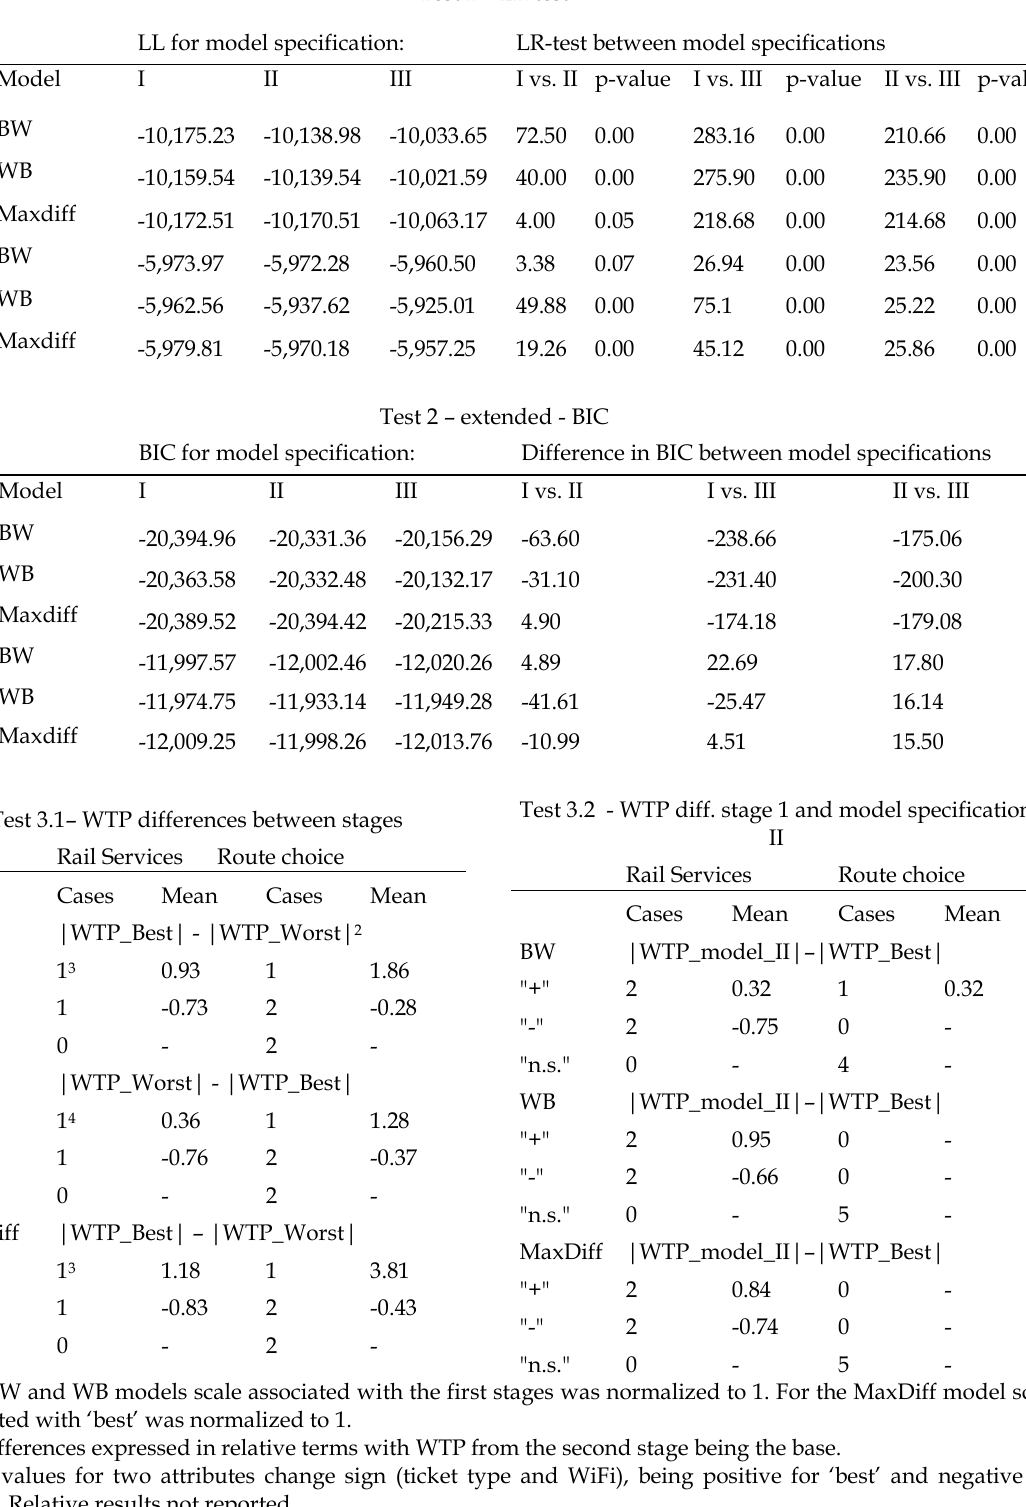
Table 10. One-off BW elicitation, results tests 1 –